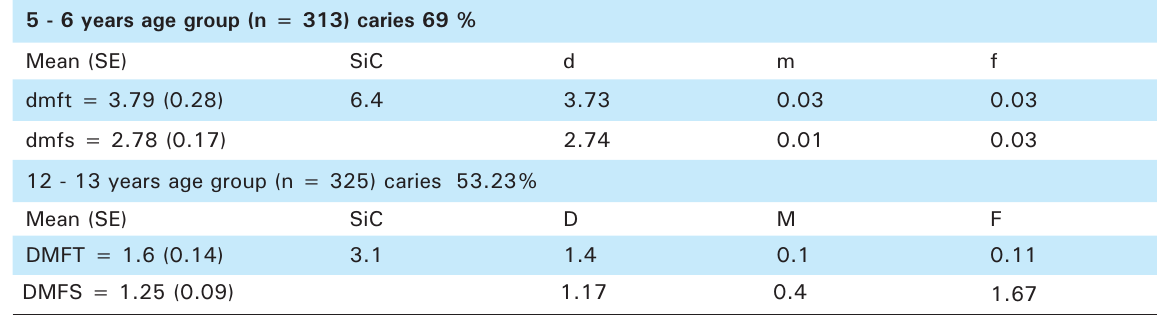
Table 1. Prevalence of dental caries, mean DMFS and other measures of caries in the 5 - 6 years and 12 - 13 years age